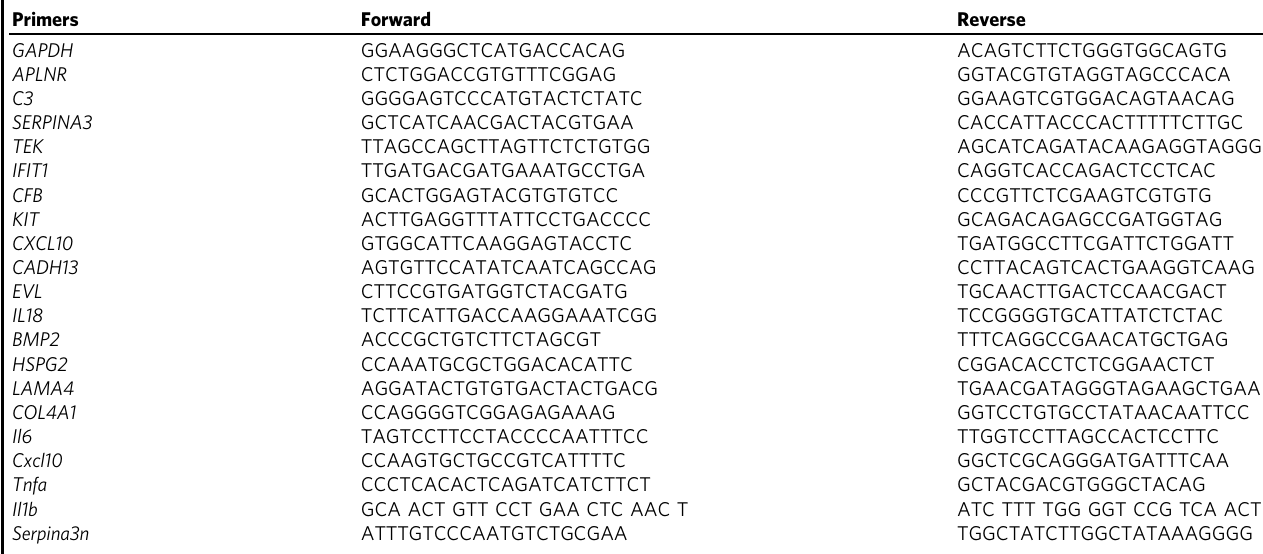
Table 1 Human and mouse primer sequences for qPCR